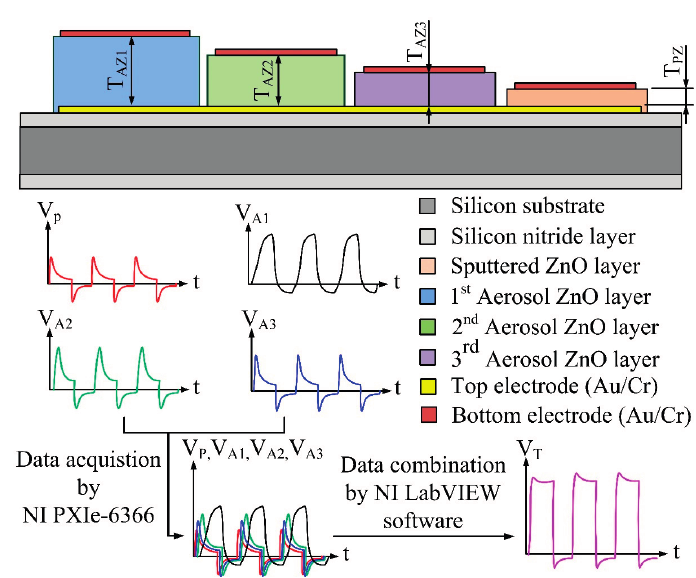
Figure 5. Schematic diagram for electrical signal treatment procedure.